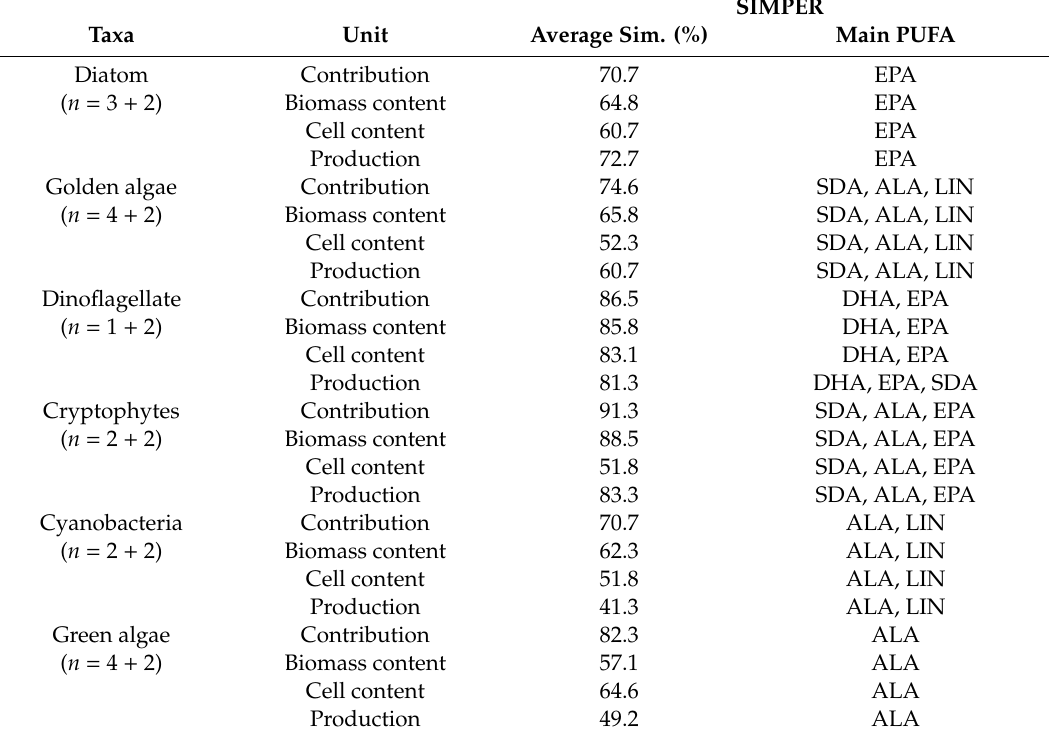
Table 3. Similarity percentages of SIMPER analysis used to assess similarity within phytoplankton class / group by the di ff erent units of the ω -3 and ω -6 PUFA abundance and main PUFAs, explaining most of the similarity. n = strain number within taxa + number of growth